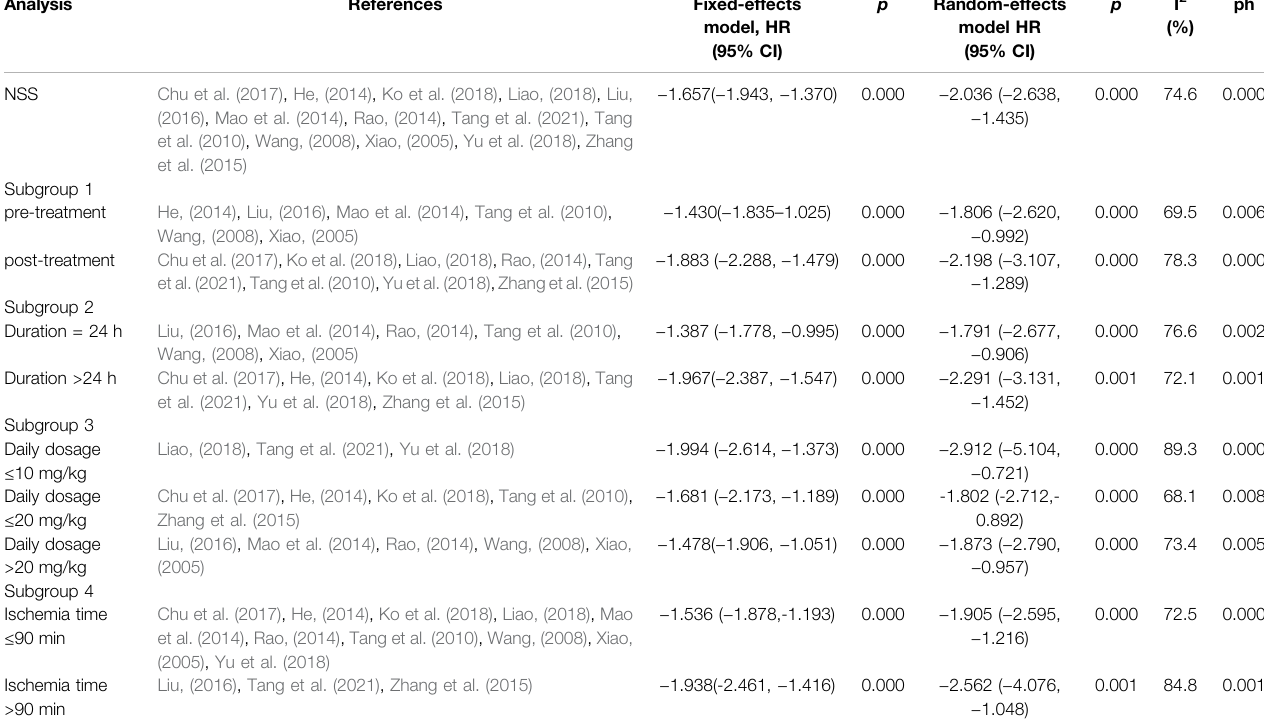
TABLE 3 | Study characteristics accounting for heterogeneity in the NSS subgroup analysis. Analysis